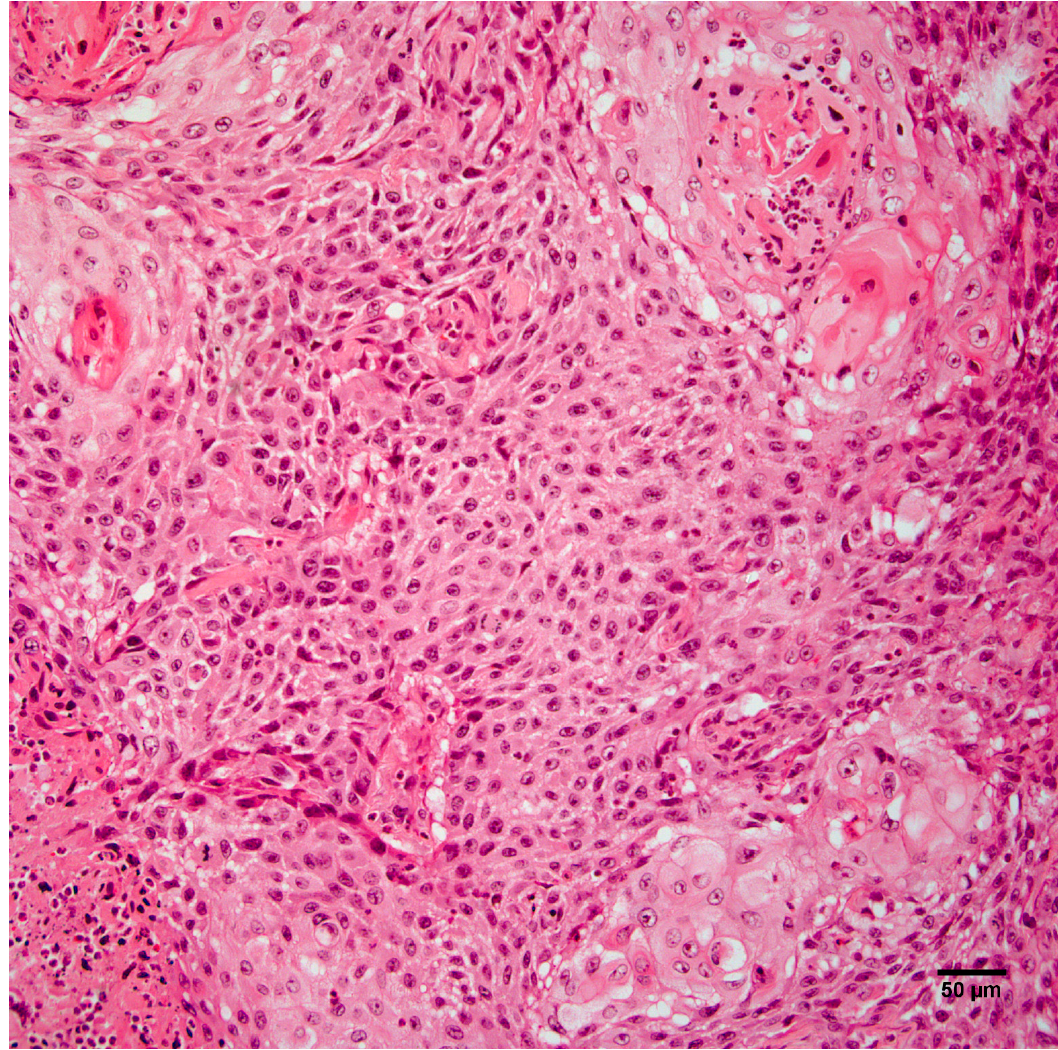
Figure 3. Neoplastic cells from the right hindlimb mass are polygonal to fusiform and occasionally display intercellular bridging. Hematoxylin and eosin staining. Scale bar 50 µm.